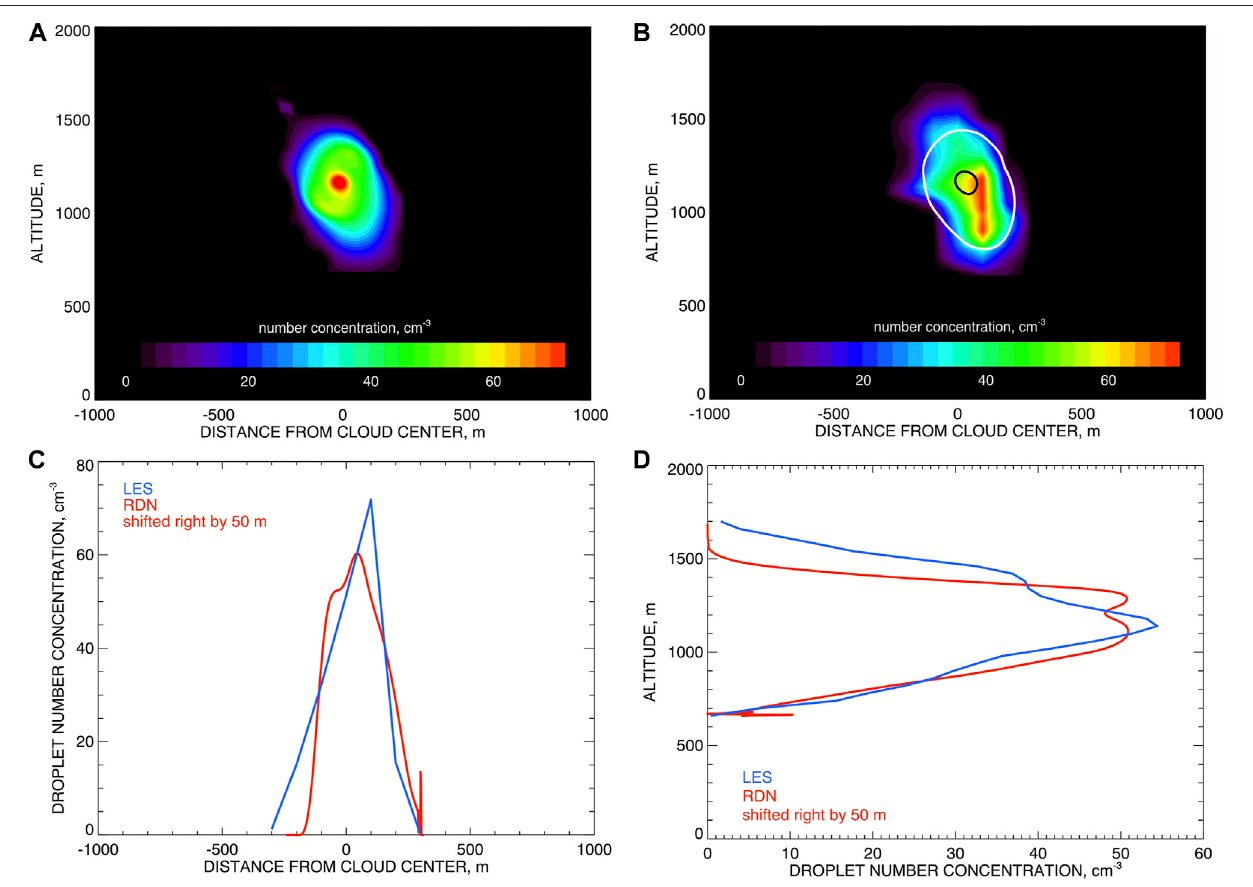
FIGURE 13 |(A) spatial distribution of droplet number concentration derived from the extinction coef fi cient in Figure 8B using Eq. 10 with r eff (cid:1) 15.5 μ m and v eff (cid:1) 0.1 (from Figures 12C,D ). (B) Comparison of the retrieved N c with the initial LES fi eld (shown in color); over-plotted white curve corresponds to retrieved N c (cid:1) 20 cm − 3 , black — to N c (cid:1) 60 cm − 3 (these values are represented by blue and red respectively in the color plot); both retrieved curves are shifted to the right by 50 m. (C) Comparison betweenretrieved (red) and initial LES (blue)dropletnumber concentrations forthe horizontal transectat 1,100 maltitude. (D) Sameas (C) but for the vertical transect at the cloud center. The retrieved N c fi elds in both bottom plots are shifted by 50 m to the right.